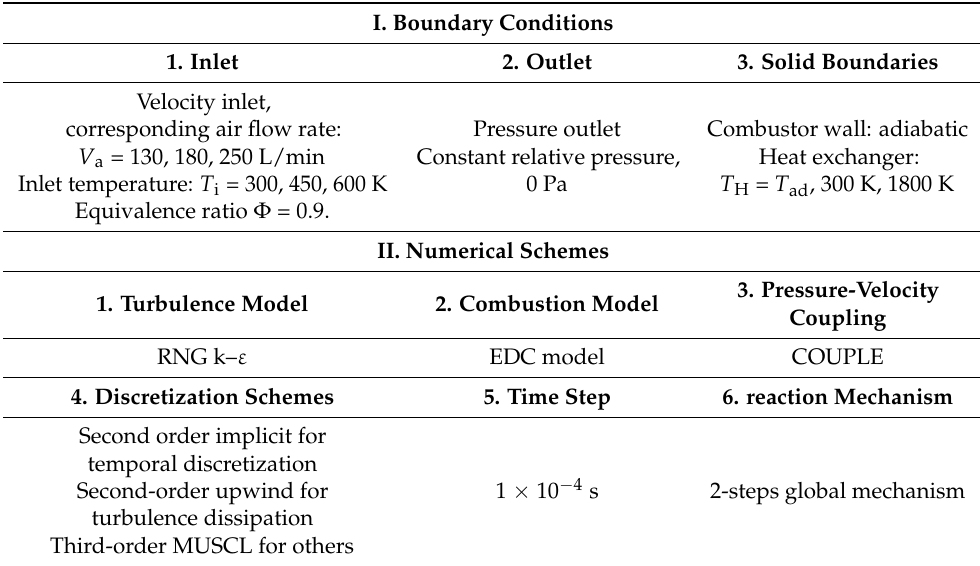
Table 1. Numerical schemes and boundary